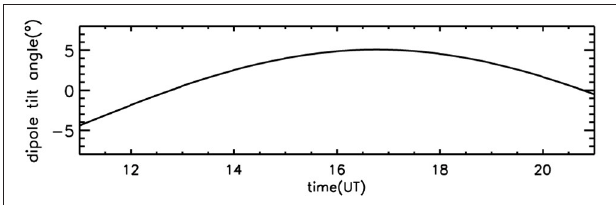
FIGURE 4 | Electron and ion precipitation fluxes measured from DMSP F13 during the northern hemisphere pass on 8 March 2008. The first panel plots total energy flux in eVcm − 2 s − 1 sr − 1 , and the second panel shows average energy in eV; Black refers to electron, red to ion. The spectrogram itself shows differential energy flux in cm − 2 s − 1 sr − 1 . The actual PCB locations are marked by the vertical red lines.